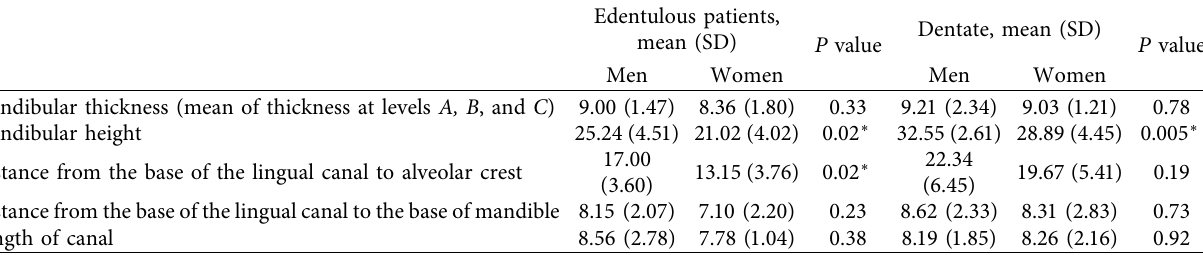
Table 4: Gender difference between mandibular features in edentulous and dentate